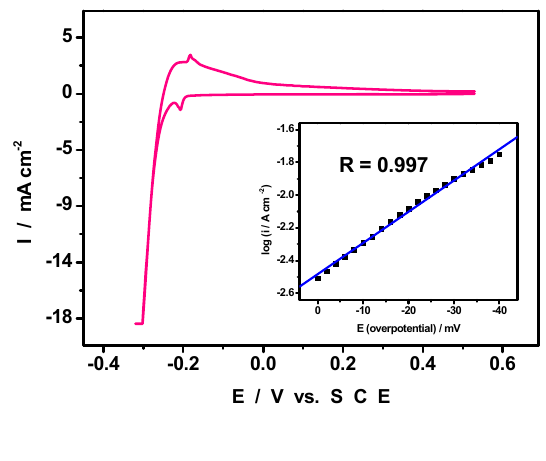
Figure 7. Cyclic voltammograms run in 0.5 M H glassy carbon-modified electrode (0.2 mg Pd 0 @POM loading) and highlighting the hydrogen evolution reaction (HER). Inset: Tafel polarization curve for the HER. The scan rate was 2 mV s -1 ; reference electrode was SCE. The electrode real surface area was